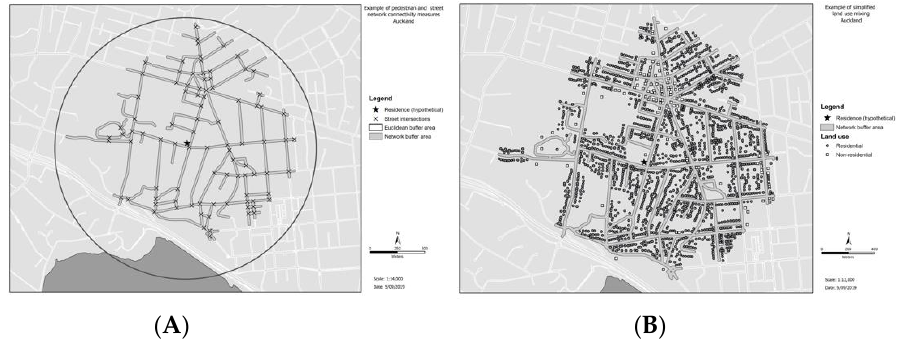
Figure 1. Graphical examples of walkability measures used in the current study for a hypothetical residential address. ( A ) depicts pedestrian network and street connectivity, ( B ) depicts a simplified (binary) example of land use mix, using residential and non-residential land use. Note that non-residential land use mix has not been separated into the individual categories used in this study for ease of